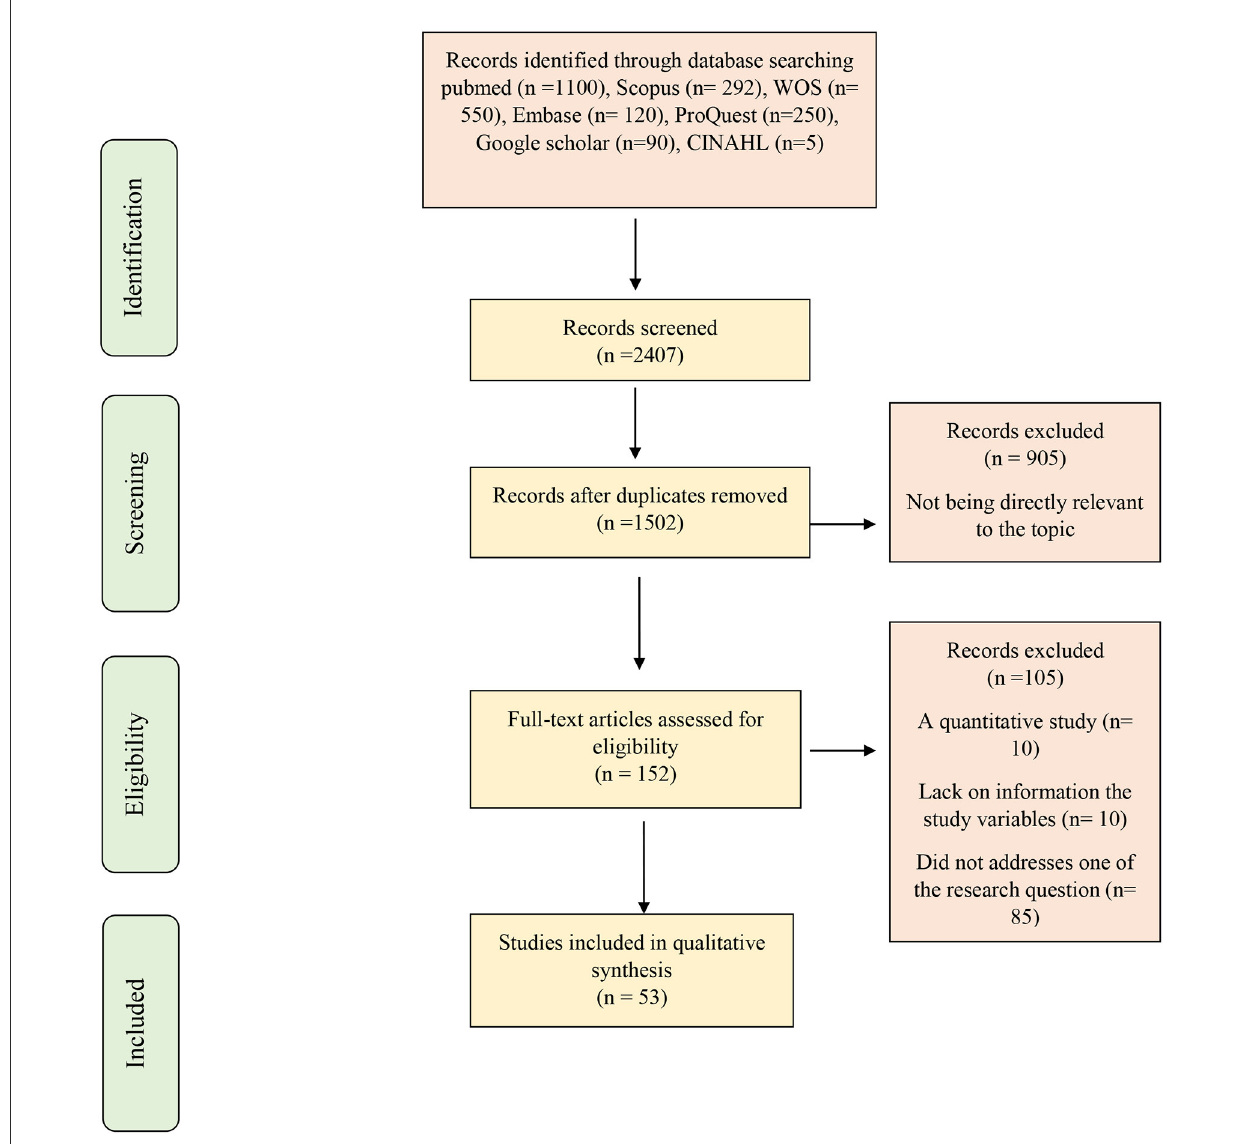
FIGURE1 PRISMA schematic flowchart of enrolment and